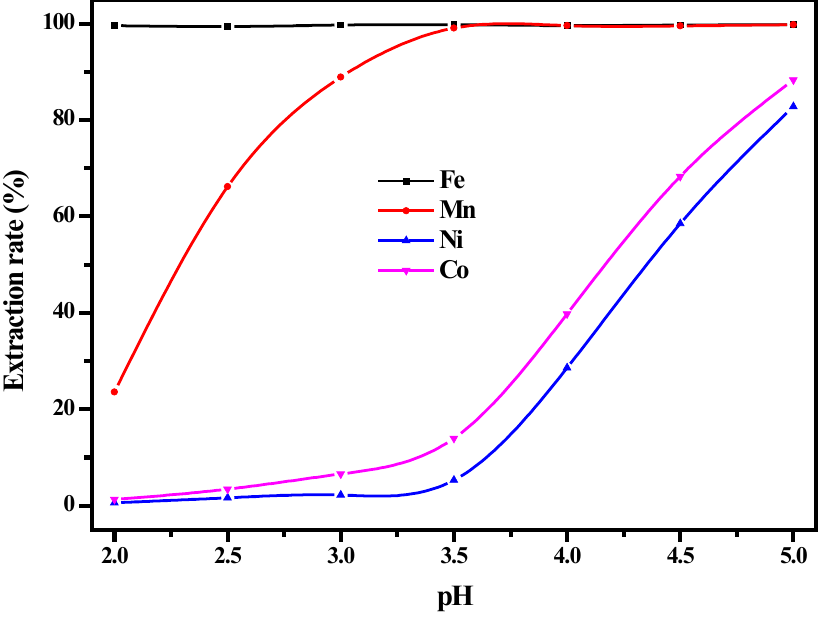
Figure 6. Effect of pH of the P204 extract on the removal rates of Fe and Mn.